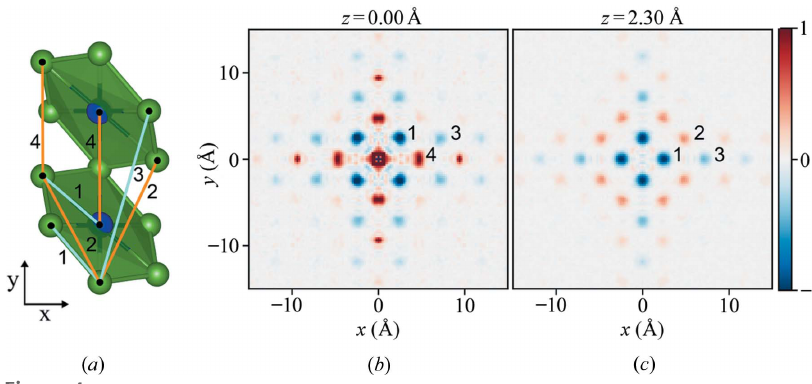
Figure 4 The 3D-m (cid:2) PDF for bixbyite. ( a ) Selected portion of the structure showing numbered vectors between atoms. ( b ) 3D-m (cid:2) PDF for the z = 0 plane. ( c ) 3D-m (cid:2) PDF for the z = 2.30 A˚ plane. The slight split of peak number 4 is an artefact, as the vector should have a component along only one